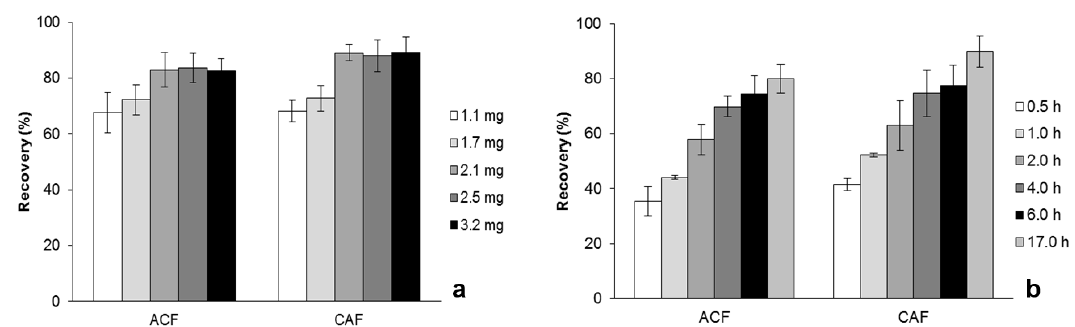
Figure 4. Effect of AC(R) mass ( a ) and equilibrium time ( b ) on the recovery of ACF and CAF by MSAµE(AC(R)-LD/HPLC-DAD.